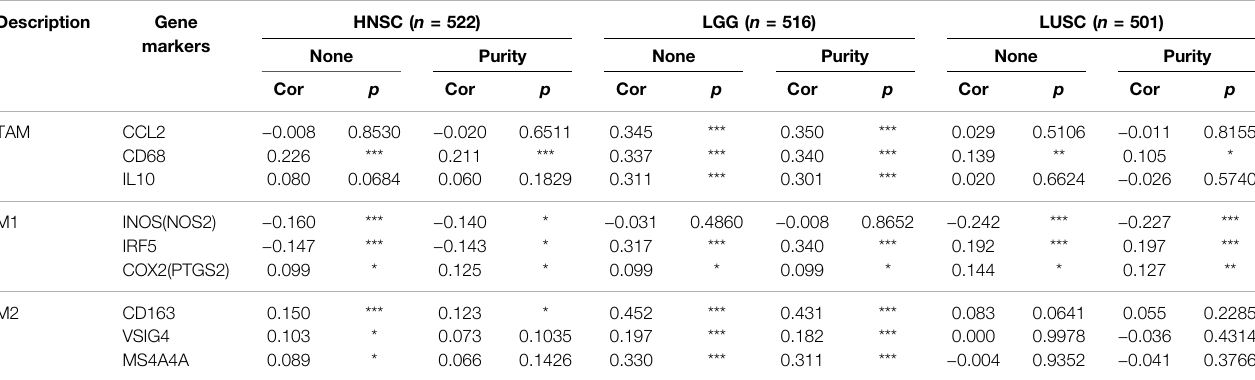
TABLE 2 | Correlations between SHC1 and gene markers of immune cells in TIMER.